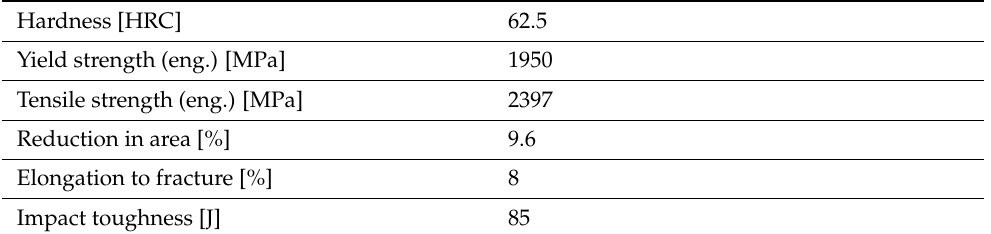
Table 2. Range of work hardness and corresponding strength and toughness of the newly developed steel.